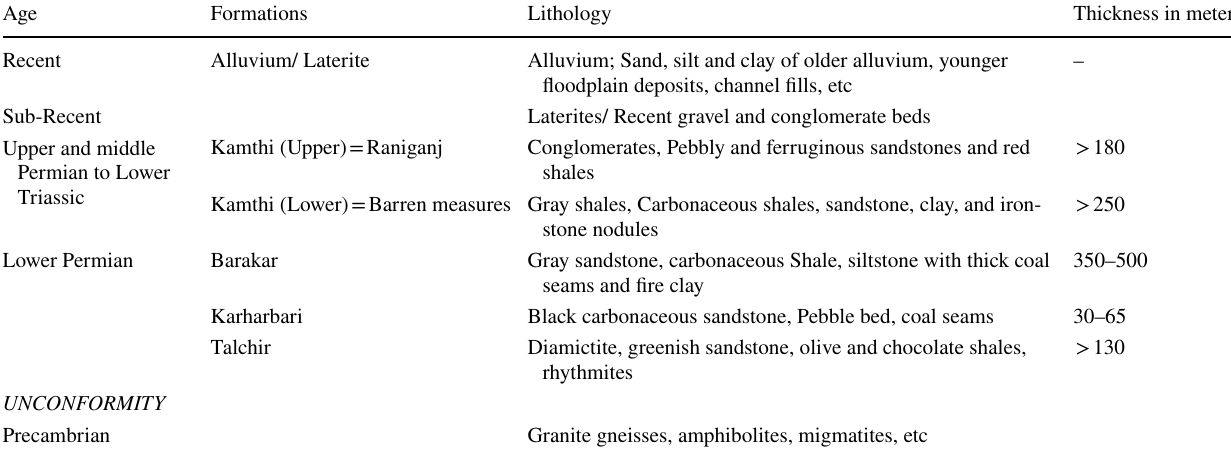
Table 1 Geological succession of the Ib-valley coalfield (Goswami et al. 2006; Senapaty and Behera